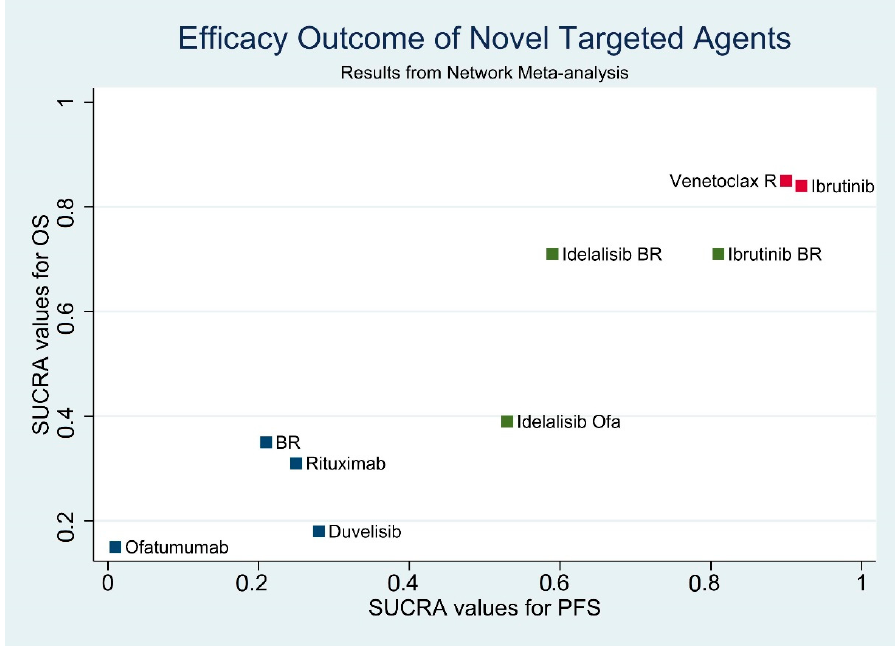
Figure 6. Efficacy outcomes for progression-free survival (PFS) and overall survival (OS) in network meta-analysis: Scatter plot. Data are reported by SUCRA values from the results of our network meta-analysis. X-axis, SUCRA values for PFS. Y-axis, SUCRA values for OS. Red nodes indicate the most effective treatment options. Green nodes indicate treatment options more effective than conventional regimens. Navy blue nodes indicate treatment options as effective as conventional regimens. PFS: Progression-free survival, OS: Overall survival, B: Bendamustine, R: Rituximab, Ofa: Ofatumumab, SUCRA: Surface under the cumulative ranking